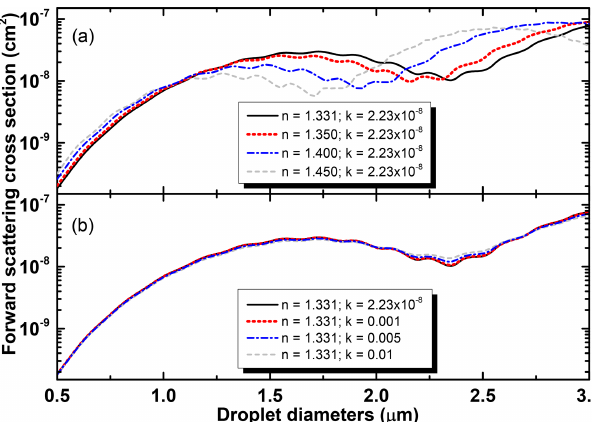
Figure 8. Computed FWSCS-diameter diagrams for the same size range, laser wavelength and angular interval of collecting scat- tered light, but for (a) different values of the real refractive index and (b) various degrees of absorption (as indicated by the imagi- nary part of the refractive index).